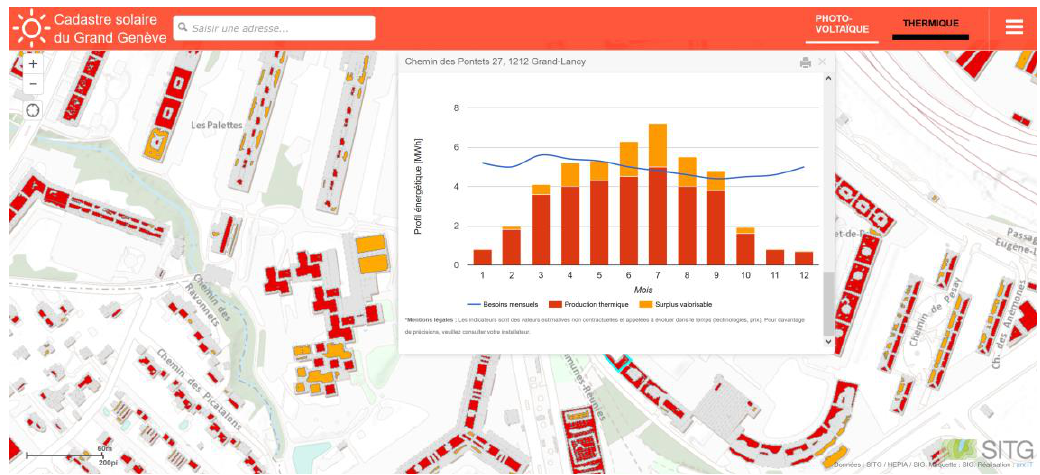
Figure 5. Screenshot of the web interface of the solar cadaster of the Greater Geneva area (with an example of a monthly solar thermal profile for a given building).